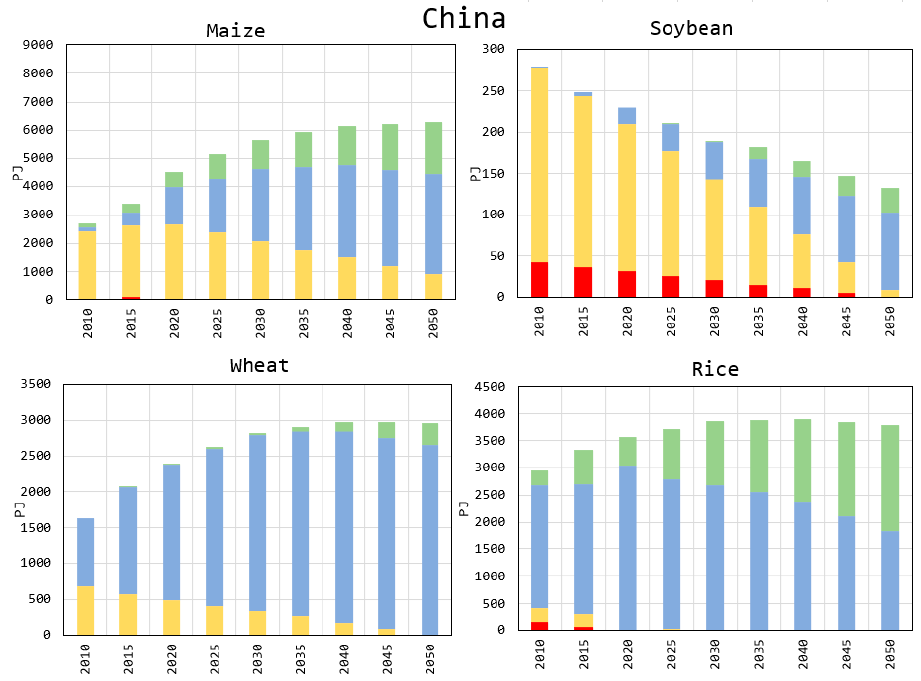
Figure 7. Technological diffusion for China in the reference scenario.